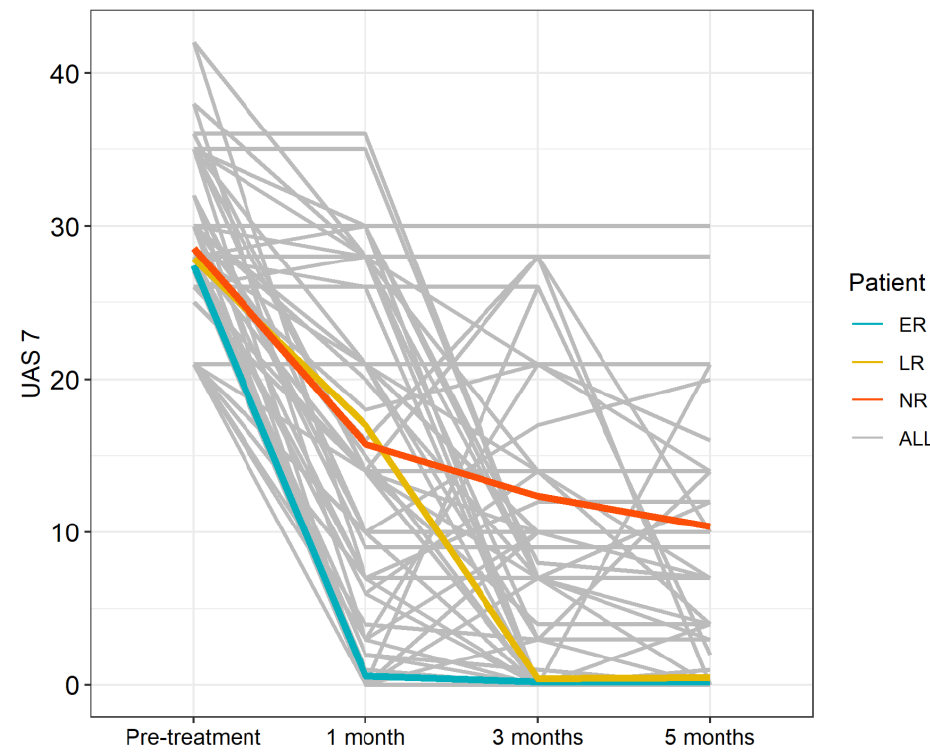
Figure 2. UAS7 Flow diagram according to CSU patient groups.